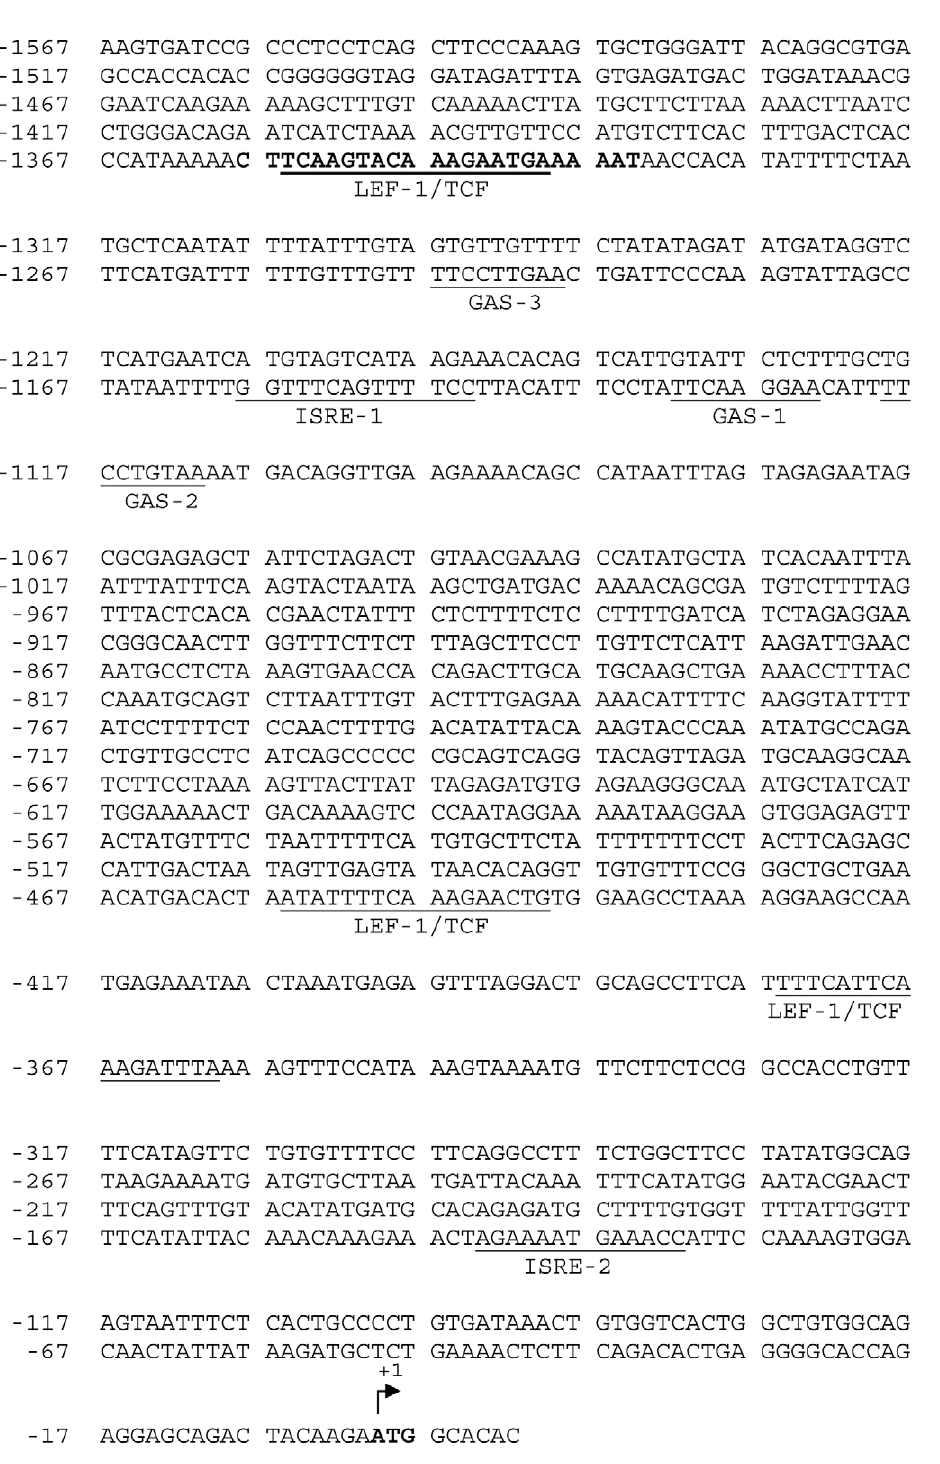
Figure 1. Cis-acting regulatory elements of the 1.6-kb promoter region of IDO1 . Nucleotides ranging from -1567 upstream to 9 downstream of the translation initiation site (ATG) are shown. Transcription factor binding sites previously described (ISRE and GAS sites) or predicted by MatInspector (LEF-1/TCF sites) are underlined and named below the sequence. The VNTR motif is in bold letters. doi:10.1371/journal.pone.0025470.g001 promoter was also evaluated after 24 h stimulation with IFN- c the relative luciferase activities of the *V1 and *V2 alleles were increased 2.5-fold compared to the insertless promoter, which and/or TNF- a , two cytokines that are known to induce IDO1 confirms that the 1.6-kb promoter region of IDO1 has significant expression. Stimulation by IFN- c and TNF- a separately showed a transcriptional activity. The transcriptional activity of the IDO1 respective 105- and 10-fold increase in luciferase activity of the